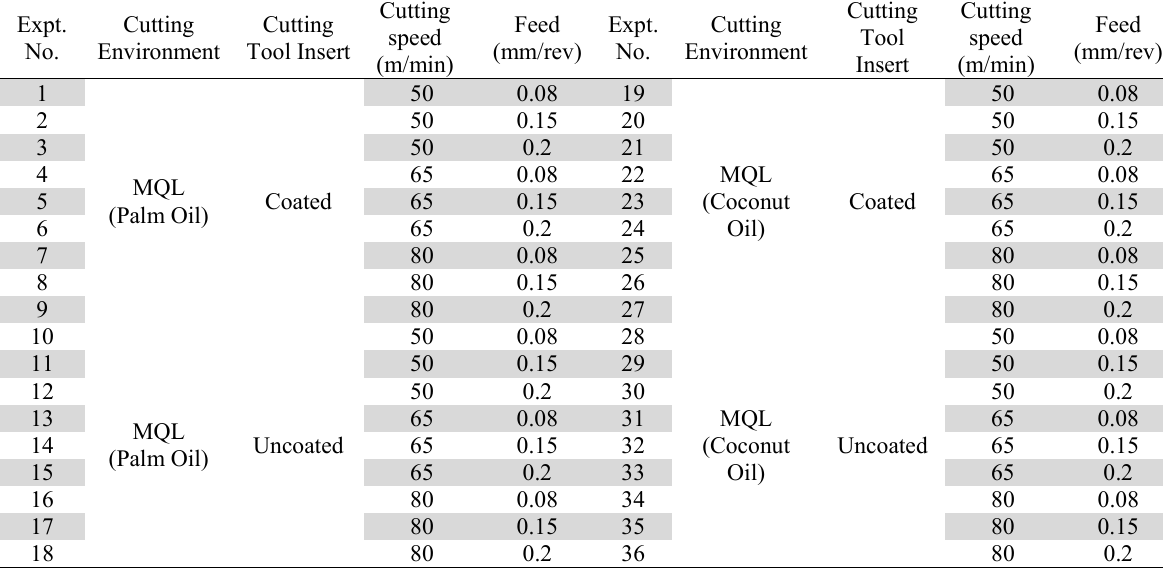
Experimental Design